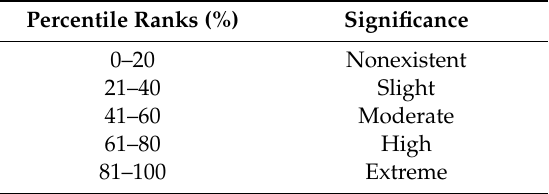
Table 5. Significance of the individual percentage values compared to the individual pain